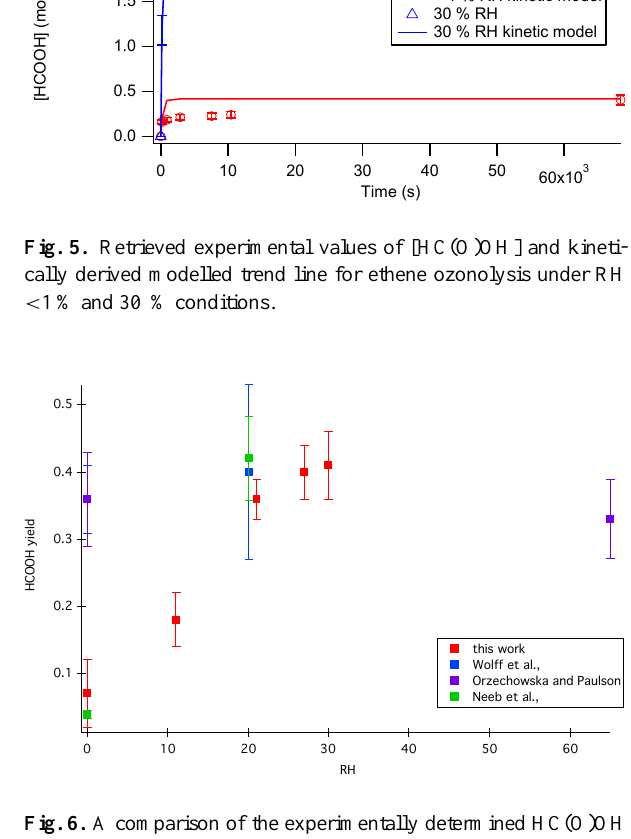
yields as a function of RH.